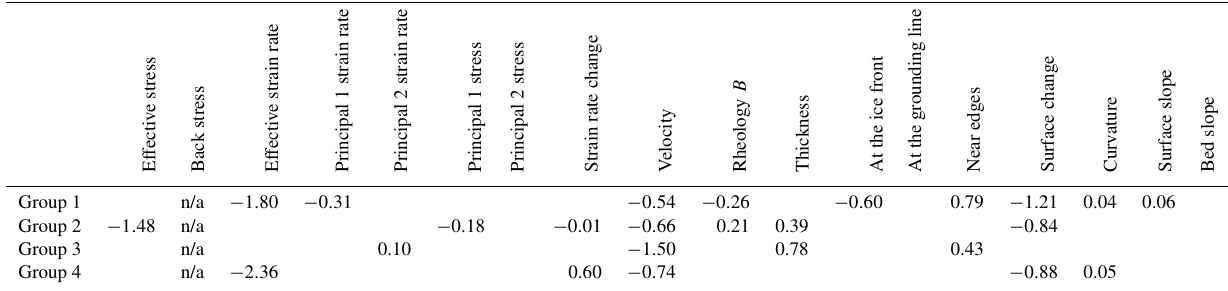
Table 4. The value of the calculated weight coefficient β in LRA for each of the included parameters on grounded ice (rounded to two decimal places).